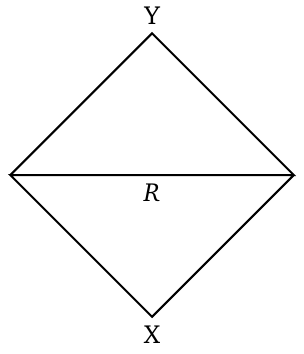
Figure 5: The domain of dependence of a boundary region R .